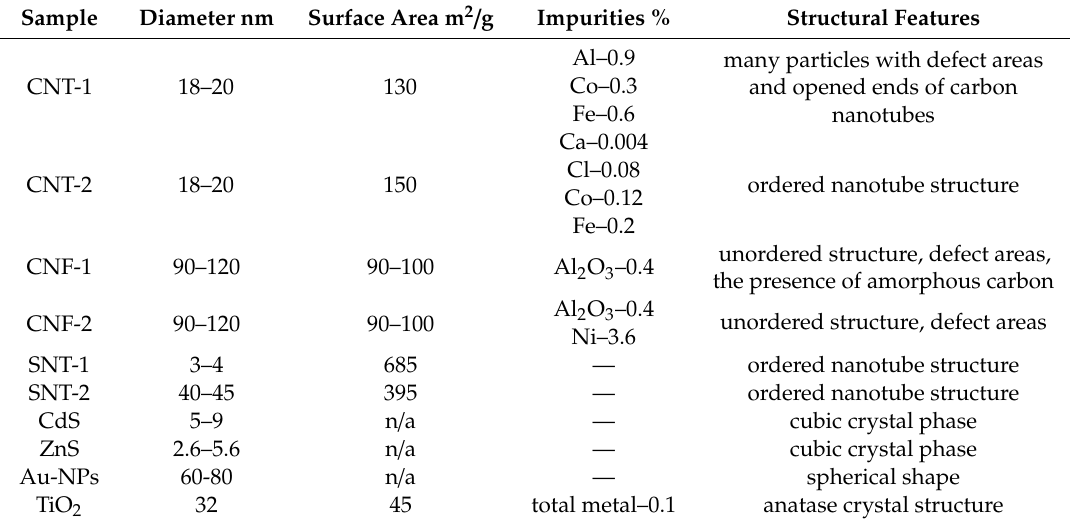
Table 1. Characteristics of the nanoparticles used in the experiment. CNT, carbon nanotube; CNF, carbon nanofibers; SNT, silicon nanotube; NP,